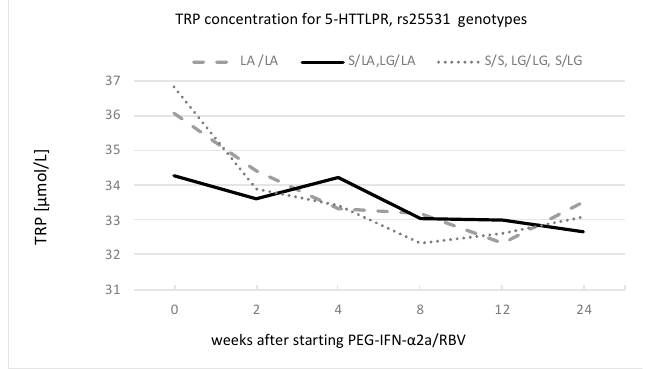
Figure 4. Changes in tryptophan concentration for TPH-2 genotypes of G/G, G/T, and T/T during PEG-IFN- α 2a/RBV treatment.